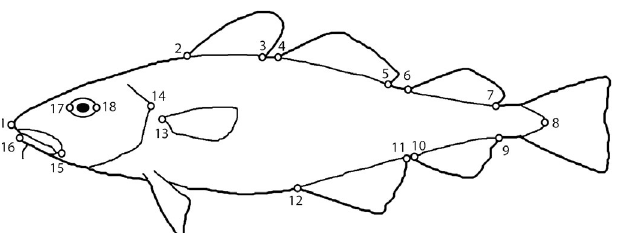
Fig. 2. Landmark points recorded on Atlantic cod Gadus morhua ; 1: Anterior-most point of premaxilla; 2: origin of first dorsal fin (DF1); 3: insertion of DF1; 4: origin of second dorsal fin (DF2); 5: insertion of DF2; 6: origin of third dorsal fin (DF3); 7: insertion of DF3; 8: posterior-most point of hy- pural plate; 9: insertion of second anal fin (AF2); 10: origin of AF2; 11: insertion of first anal fin (AF1); 12: origin of AF1; 13: origin of pectoral fin; 14: posterior-most point of operculum; 15: posterior-most point of maxilla; 16: anterior-most point of dentary; 17: anterior-most point of the eye; 18: